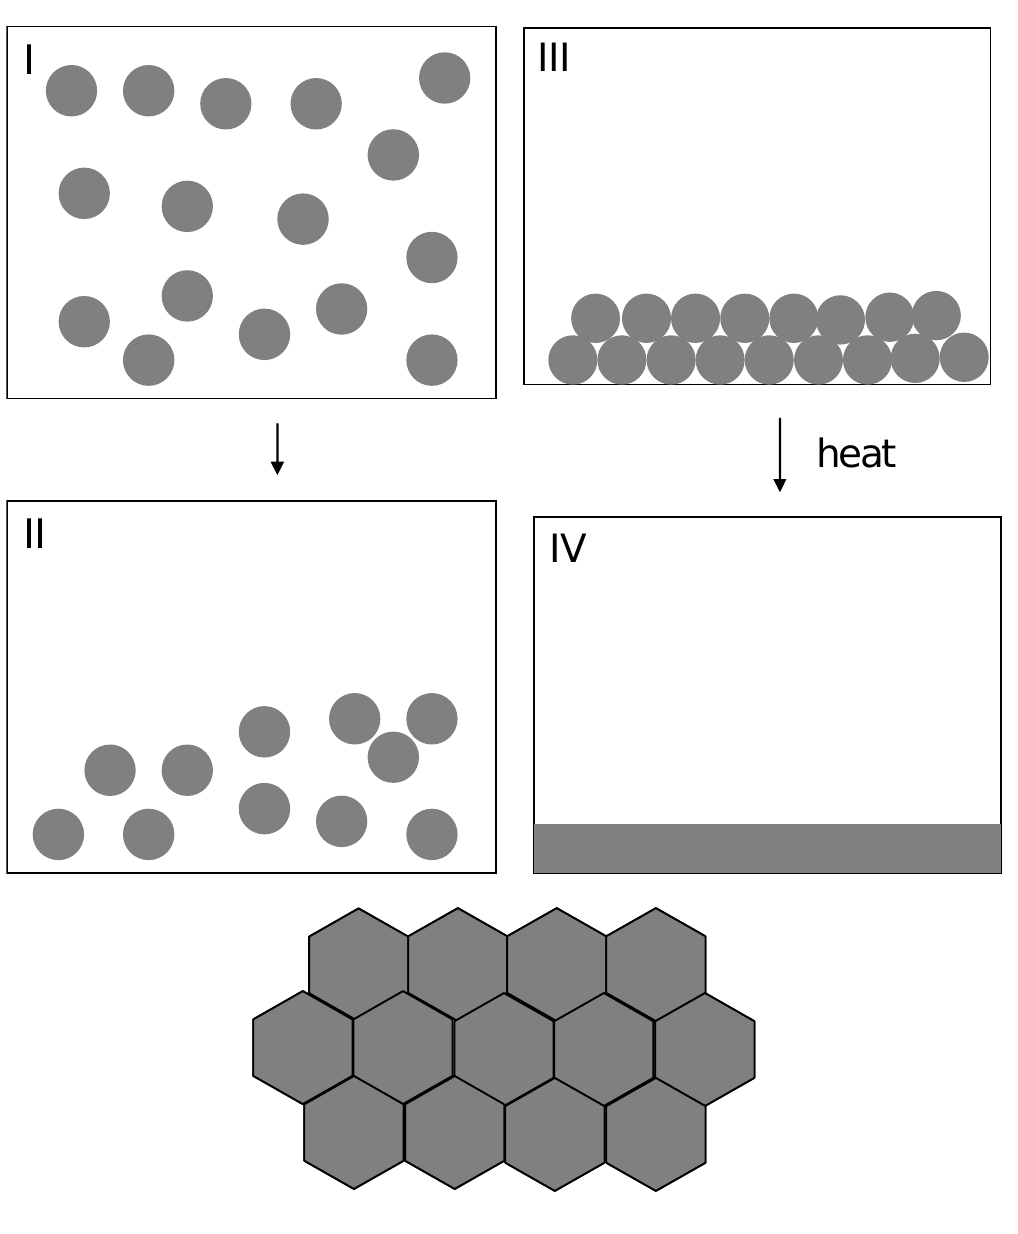
Figure 7. Process of film formation of polymer particles on a flat substrate and top view of the uniform